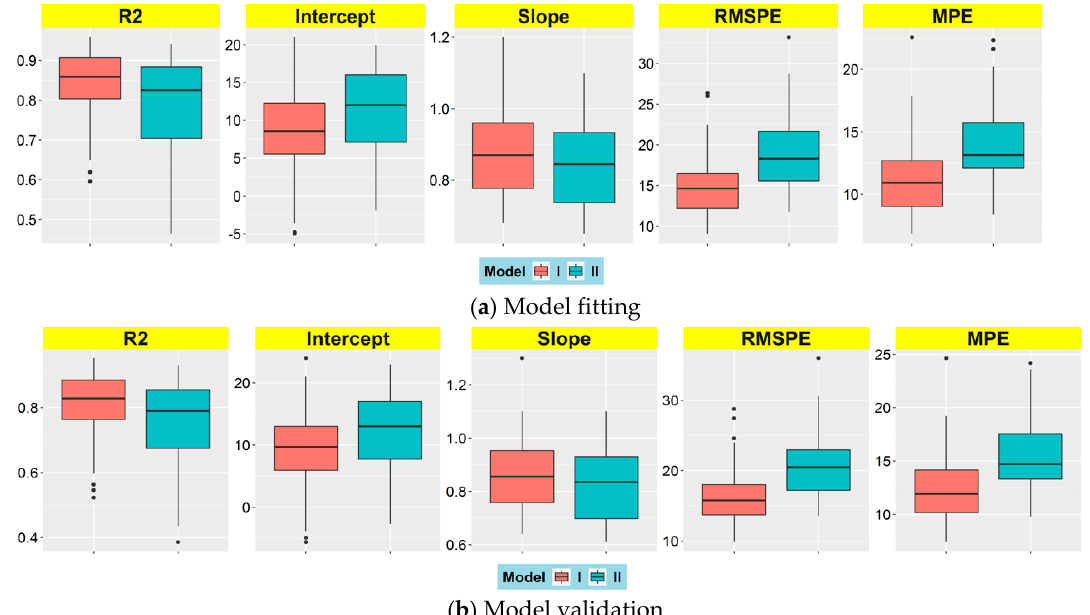
Figure 2. Boxplots statistics of estimation performance at all the 36 sites for R 2 , intercept, slope, root mean squared prediction error (RMSPE) ( µ g / m 3 ), MPE ( µ g / m 3 ). ( a ) Model fitting; ( b ) model validation. ‘I’ denotes models using PM 2.5 24-h average, and ‘II’ denotes models using PM 2.5 time average of 10:00 and